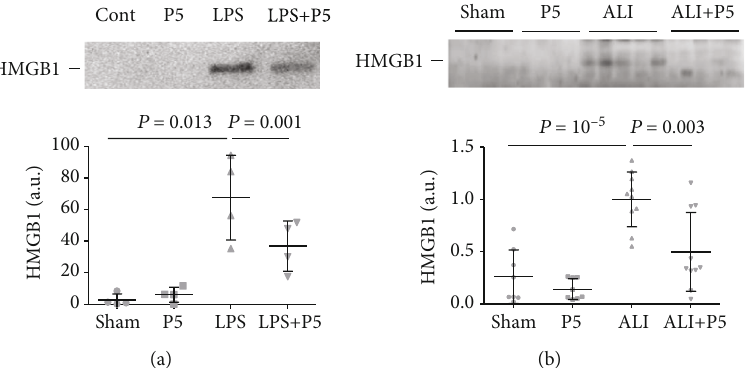
Figure 3: P5 inhibited the extracellular release of HMGB1 in vitro and in vivo . (a) Cultured HPMVEC were divided into Cont, P5 (20 μ g/ml), LPS (0.5 μ g/ml), and LPS+P5 (0.5 μ g/ml LPS and 20 μ g/ml P5) groups. At 16 hr post-LPS challenge, culture medium was collected, concentrated, and subjected to Western blotting analysis of HMGB1. n = 4 . (b) Balb/c mice were divided into 4 groups: Sham (surgery +saline), P5 (8 mg/kg P5), ALI (5 mg/kg LPS+saline), and ALI+P5 (5 mg/kg LPS + 8 mg/kg P5). ALI was induced by intratracheal instillation of LPS. Saline or P5 was administered twice through ip at 2 and 16 hr post-ALI induction. BALF was collected at 4hr after second saline or P5 administration, concentrated, and subjected to Western blotting analysis of HMGB1. a.u.: arbitrary unit; n = 10